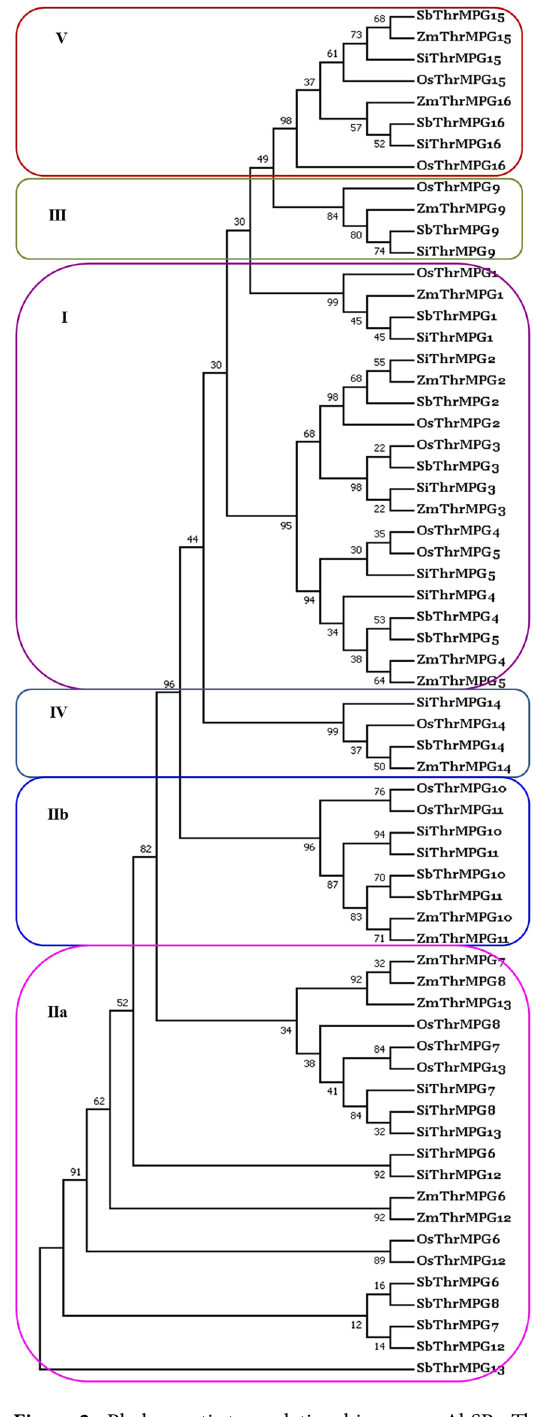
Figure 2. Phylogenetic tree relationship among AbSR –ThrMPG encoding proteins of rice, foxtail millet, sorghum and maize. Full length amino acid sequences of Oryza sativa (OsThrMPG), Setaria italica (SiThrMPG), Sorghum bicolor (SbThrMPG), and Zea mays (ZmThrMPG) were aligned by Clustal W and an unrooted maximum likelihood tree constructed with 1000 bootstrap iterations. Number at nodes represents the bootstrap values of the consensus tree obtained. The phylogenetic tree classified the ThrMPG proteins into (I–V)